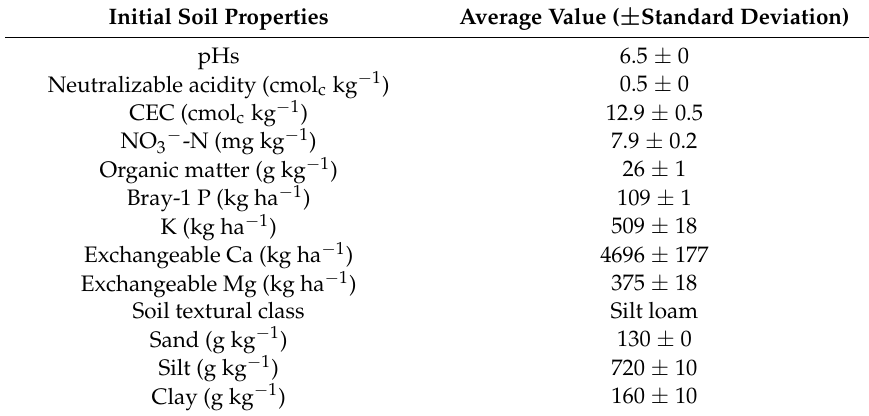
Table 1. Selected initial properties of bulk soil collected from University of Missouri’s Greenley Research Center in 2013 for use in the greenhouse study. Values are averaged over three replications. Initial Soil